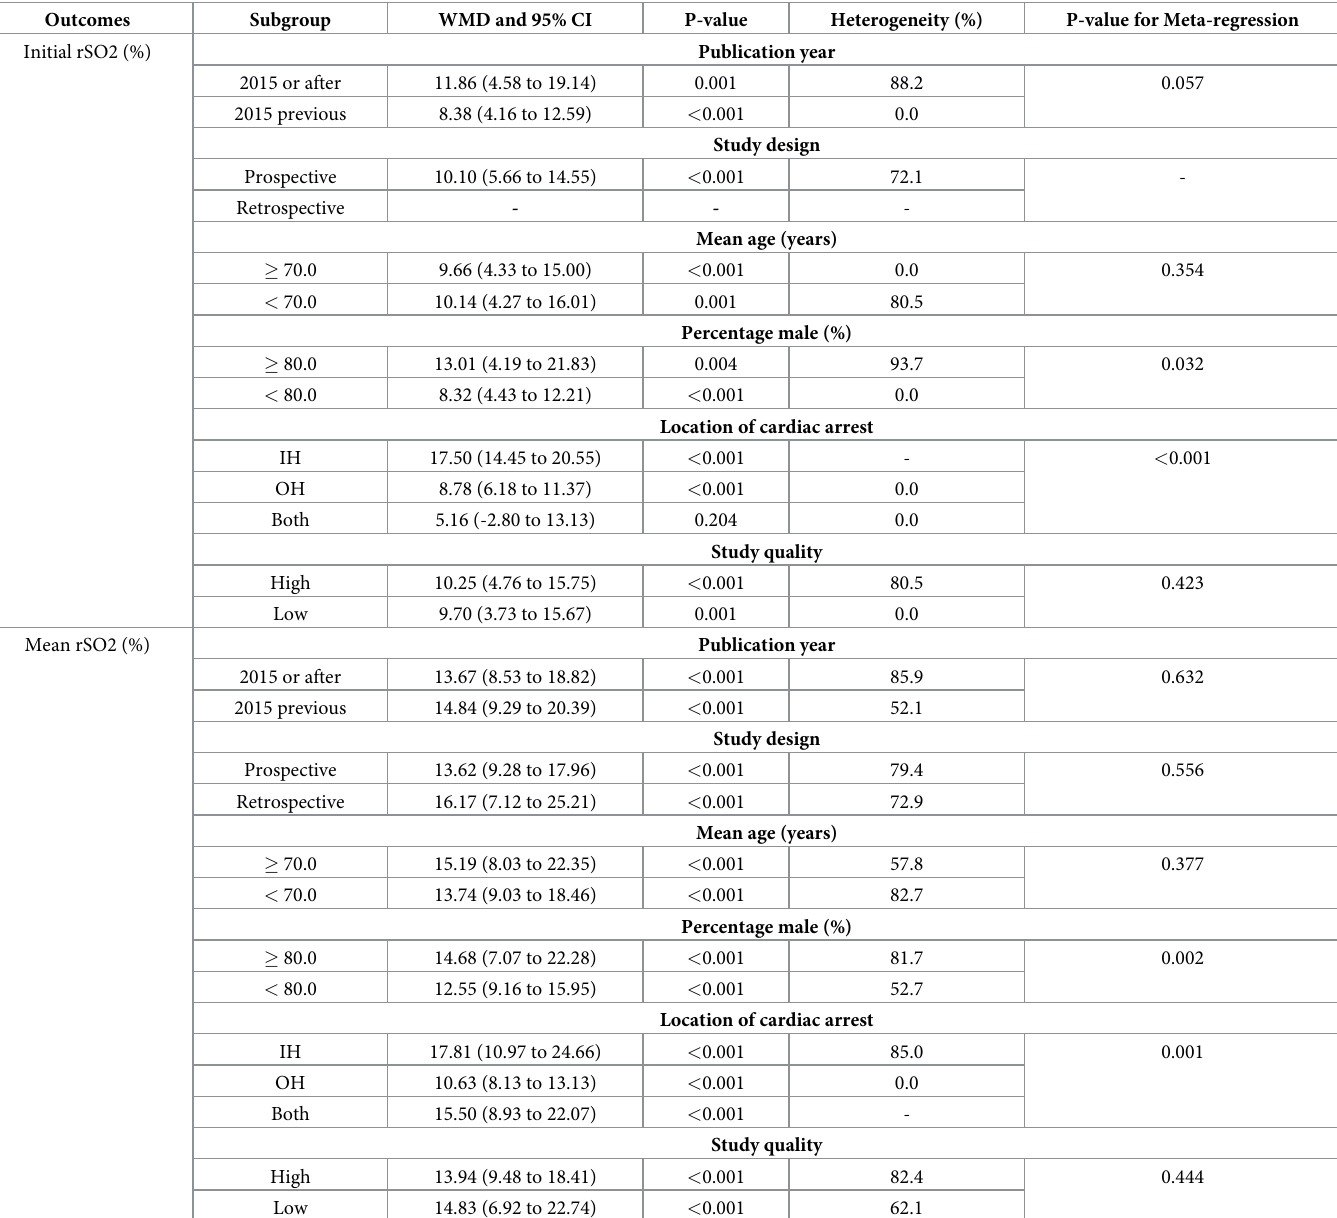
Table 3. Subgroup analyses for initial rSO2 and mean